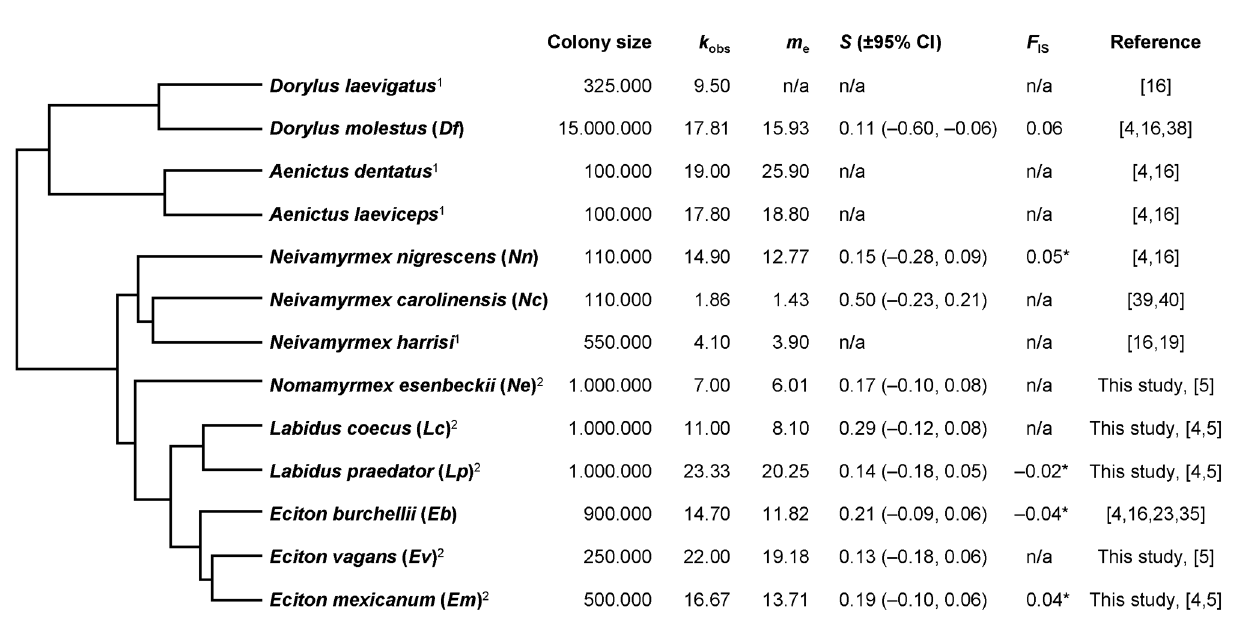
Figure 1. Phylogenetic tree (following Brady [7] ) of all 13 army ant species for which paternity data is available so far. Data on colony size, observed and effective paternity frequency ( k obs and m e ), effective-number-index of paternity skew ( S ) and inbreeding coefficient ( F IS ) are given next to the tree. Colony size is represented by the average approximation of the number of workers in normal mature colonies as given in the literature. k obs and m e are the means given in this study or in the literature, from which S was calculated [47,64]. Mean F IS is also taken from this study or the literature (asterisks mark significance). Species abbreviations, as used in the following figure legends, are given in brackets behind species names. n/a, data not available. 1 Data on these species are listed for the sake of completeness, but have not been used in this study because m e estimates were either not published, higher than the respective k obs , or assumed to be underestimated [16], so that in these cases the S -index could not be calculated or would have been biased. 2 Paternity and inbreeding data on these species are the result of this study.